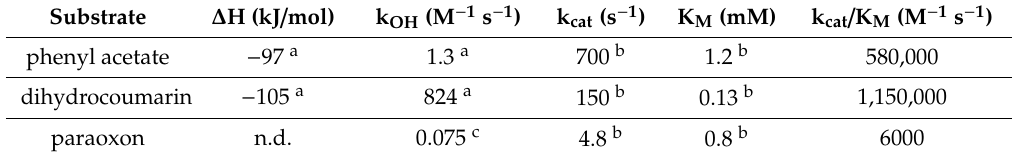
Table 1. Enthalpy ( ∆ H) and rate (k OH ) changes for the alkaline hydrolysis of phenyl acetate, dihydrocoumarin, and paraoxon. k OH is the second-order rate constant for the hydroxide ion reaction with the carbonyl groups of various substrates. k cat , K M and k cat / K M are the turnover number, the Michaelis constant and catalytic efficiency, respectively. a [35]; b [19]; c